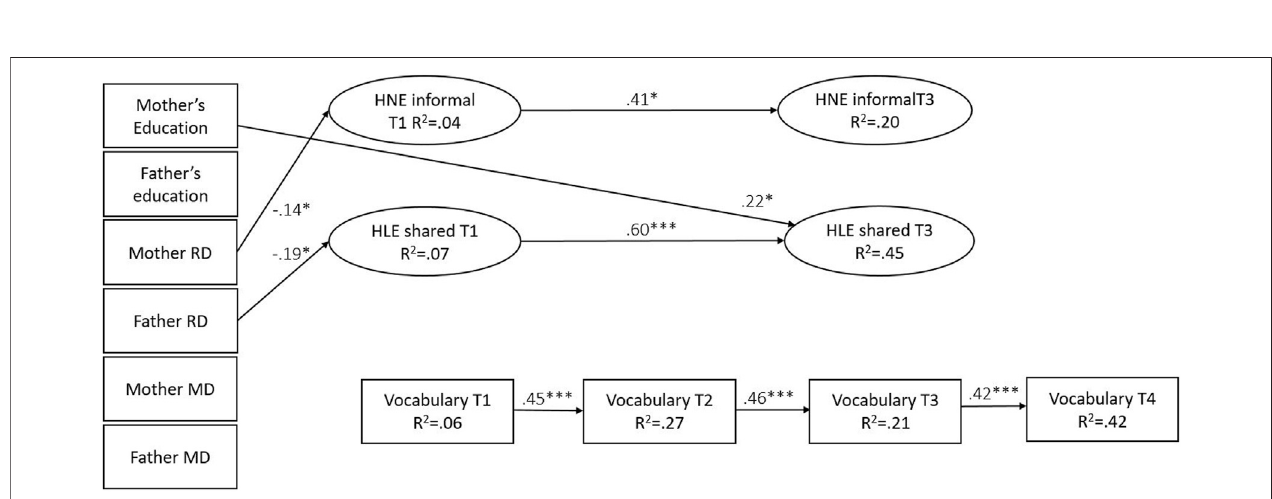
FIGURE 9 | The model for vocabulary with the signi fi cant standardized estimate. Note: In addition to the regression paths depicted, there was one signi fi cant residual correlation: between HNE and HLE at T1 (stand. estimate (cid:1) 0.42***).